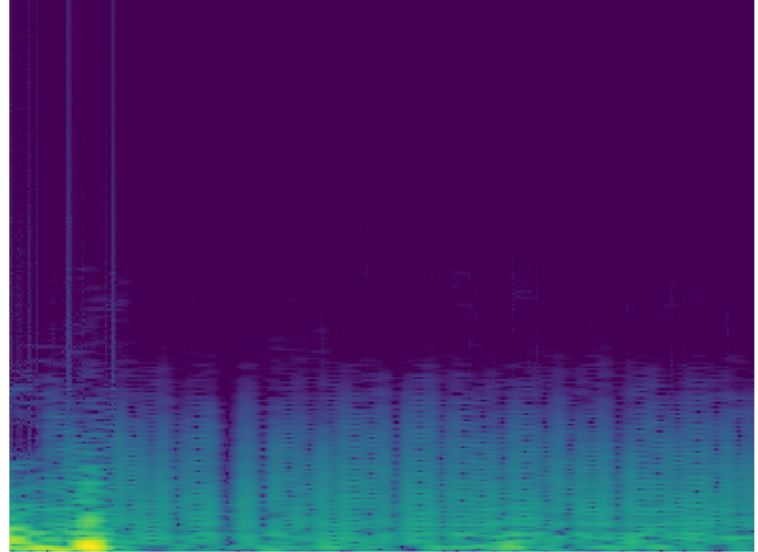
Figure 10. Spectrum of ECG signal with normal rhythm.